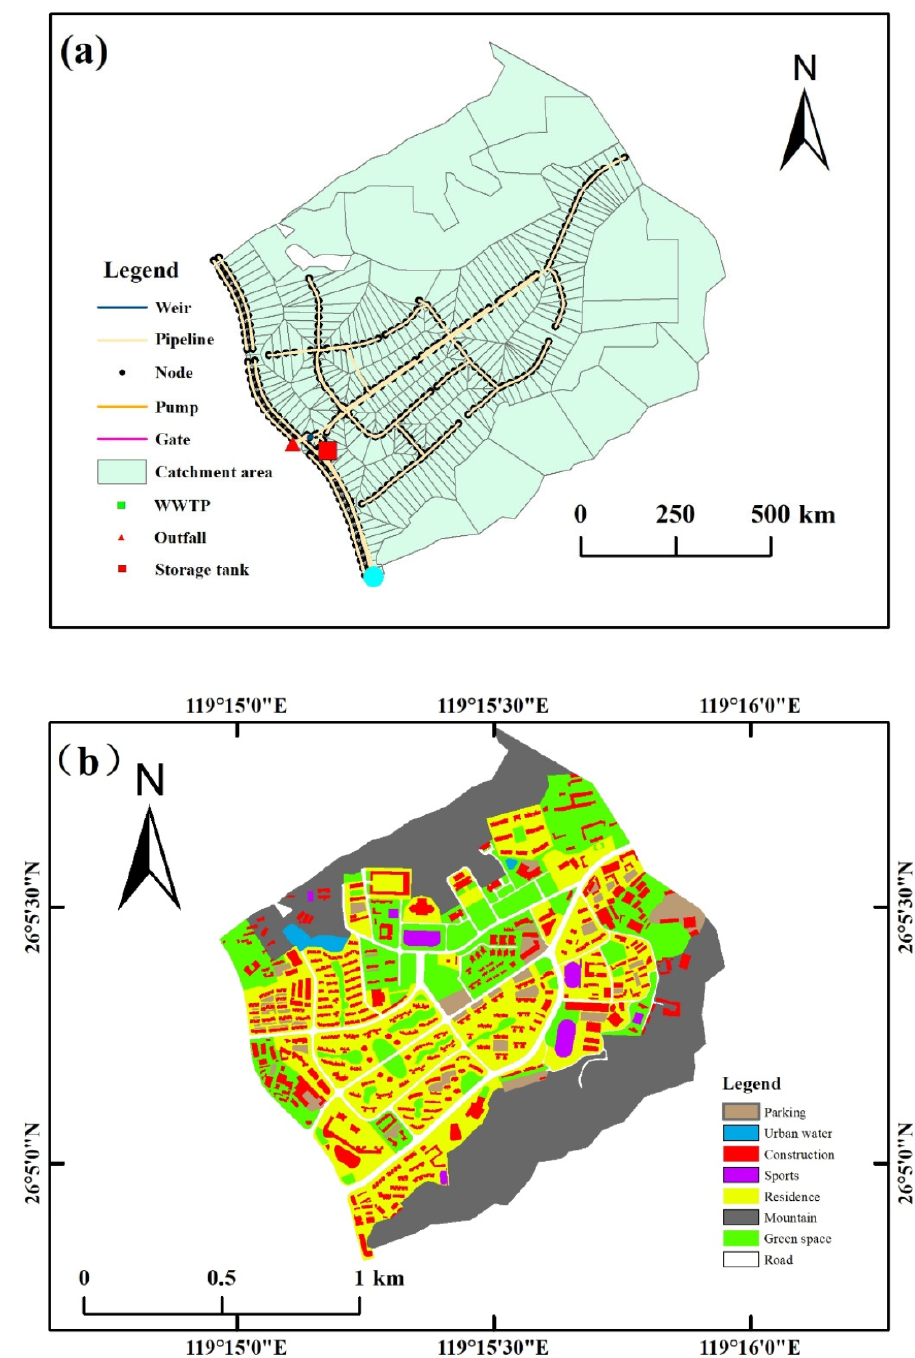
Figure 2. The detail information of study area: ( a ) pipe network system; ( b ) land utilization